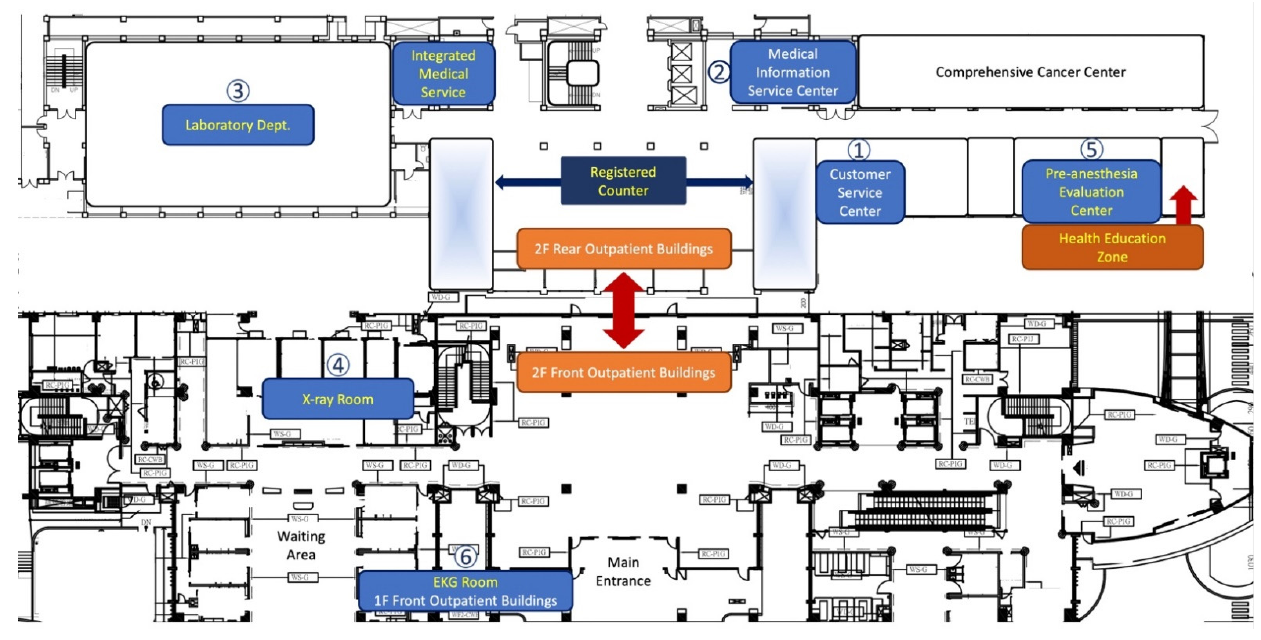
Figure 3. Floor Plan Following Renovation of the Rear Outpatient